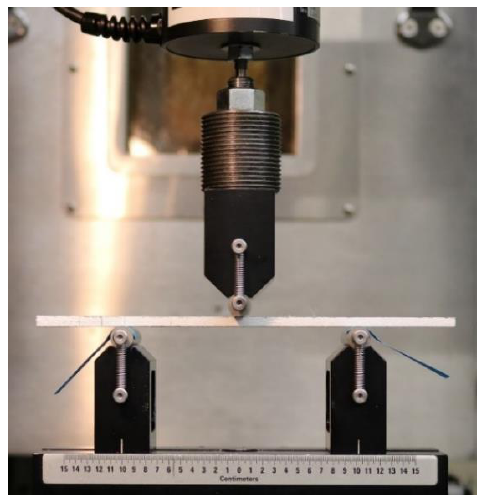
Figure 6. Mode II delamination test setup.